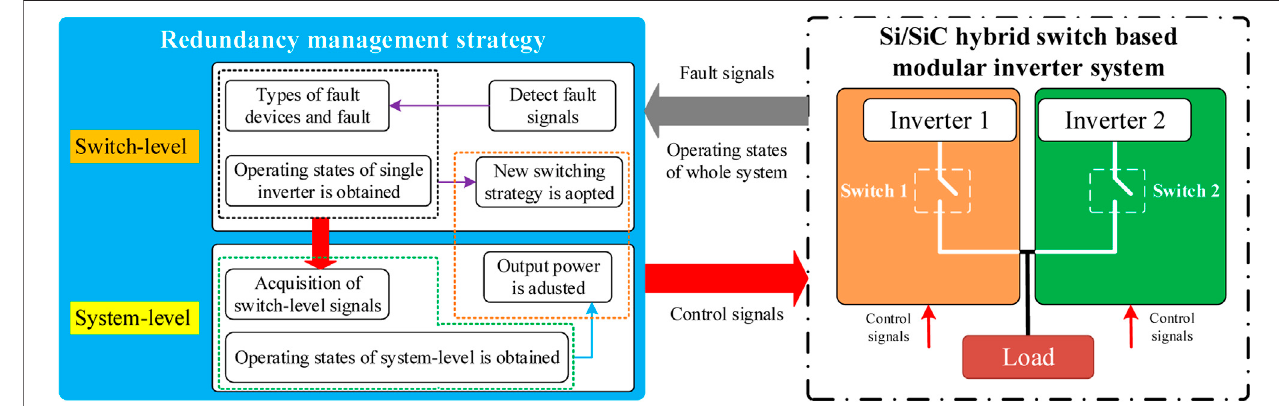
FIGURE 4 | Principle of the redundancy management strategy.